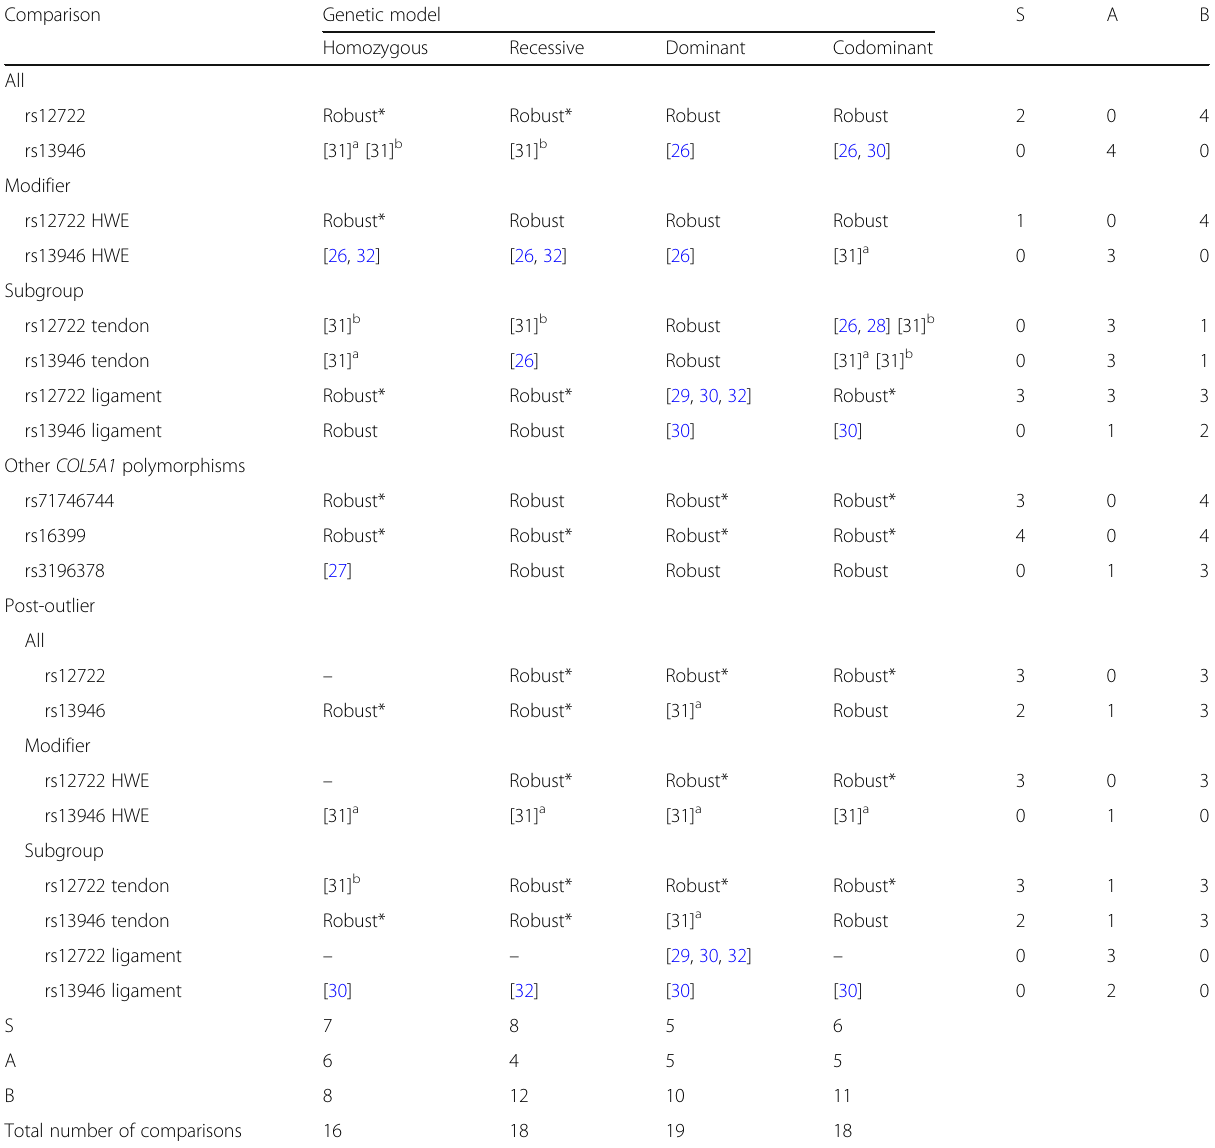
Table 5 Sensitivity analysis for all COL5A1 comparisons